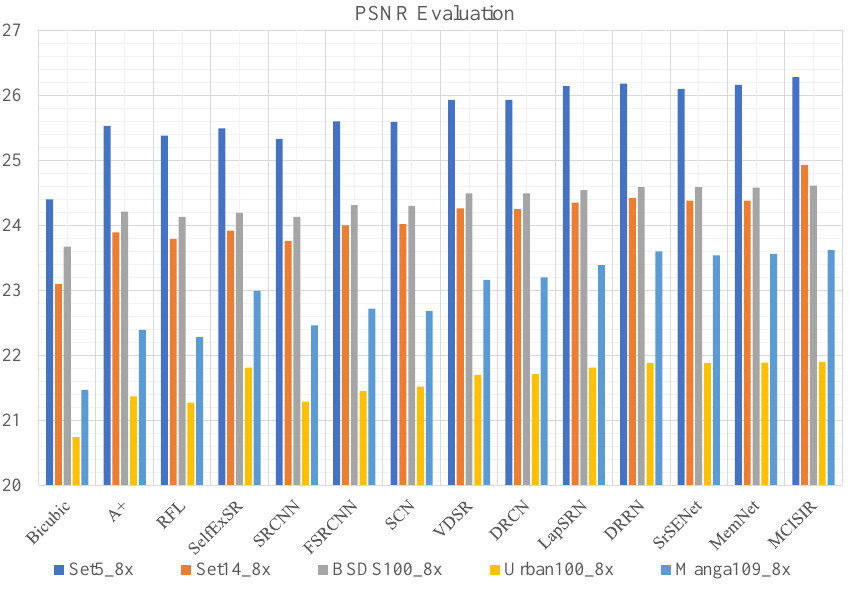
Figure 12. Plot the PSNR of all publicly available test image datasets versus different algorithms on enlargement scale factor 8 ×